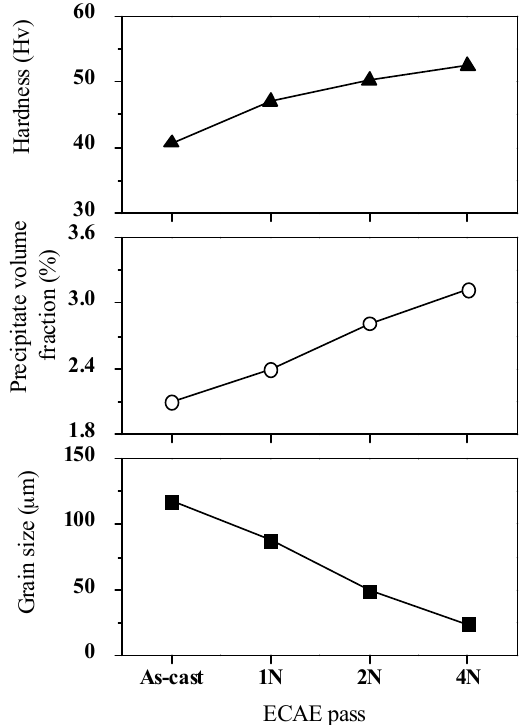
Figure3. Grain size, hardness, and precipitate fraction of the Mg-Sn alloys before and after ECAE processing.